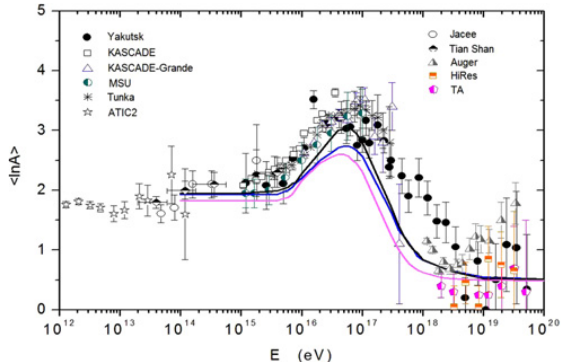
Figure 5. The mass composition of the highest energy Cosmic rays is obtained at Yakutsk. Model QGSJETII-03.